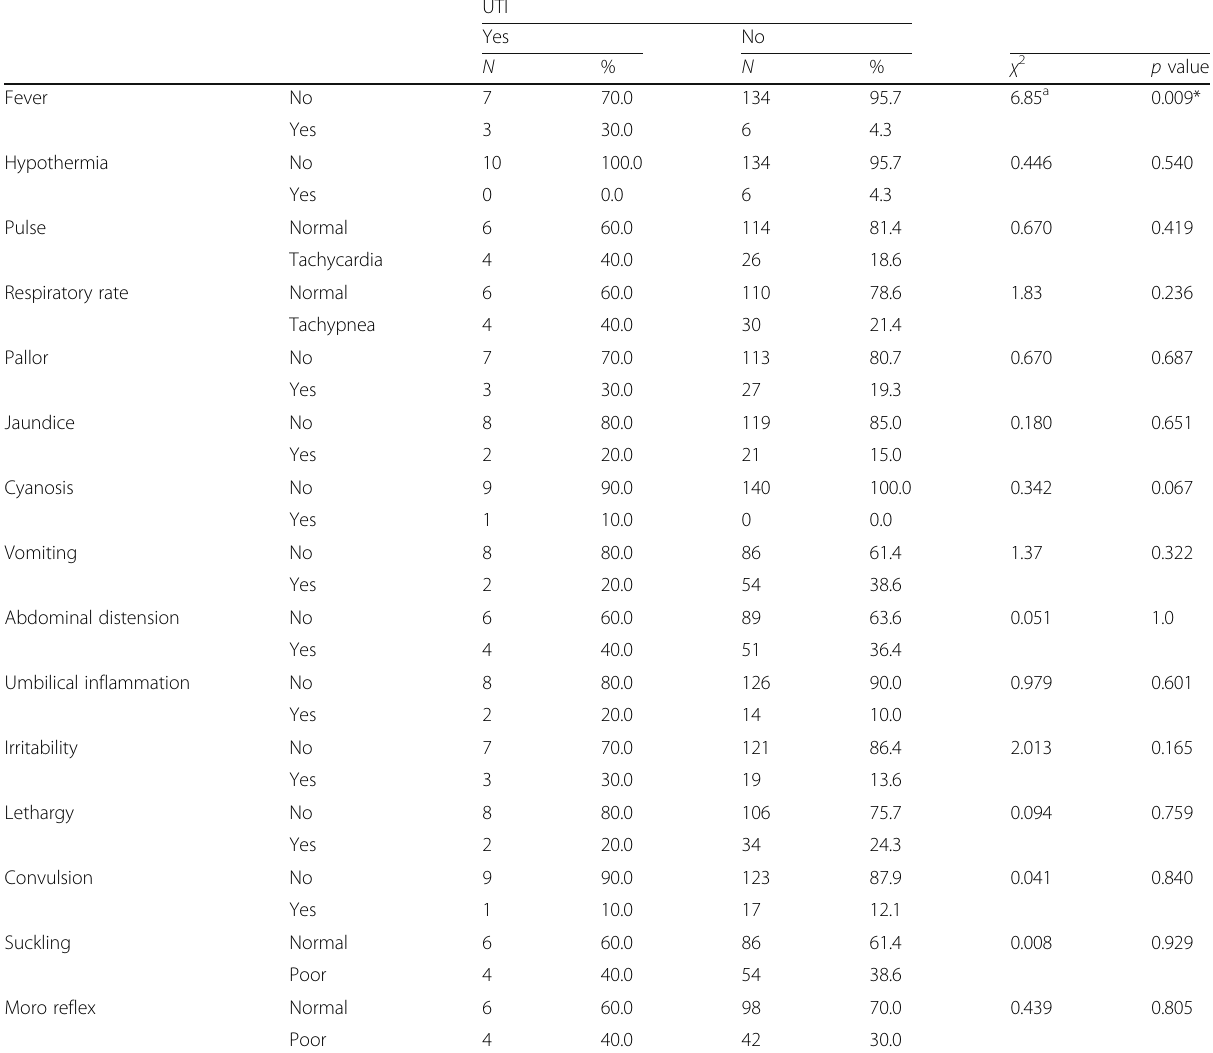
Table 5 Association of clinical manifestations and urinary tract infection